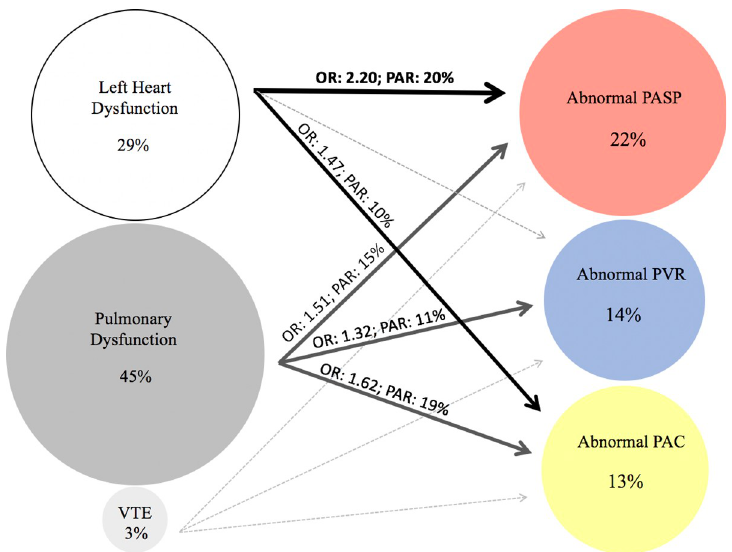
Fig 2. Prevalence, association, and PAR of left heart disease, pulmonary dysfunction, and VTE for abnormalities of PASP, PVR, and PAC. OR, odds ratio; PAC, pulmonary arterial compliance; PAR, population attributable risk; PASP, pulmonary artery systolic pressure; PVR, pulmonary vascular resistance; VTE, venous thromboembolism.